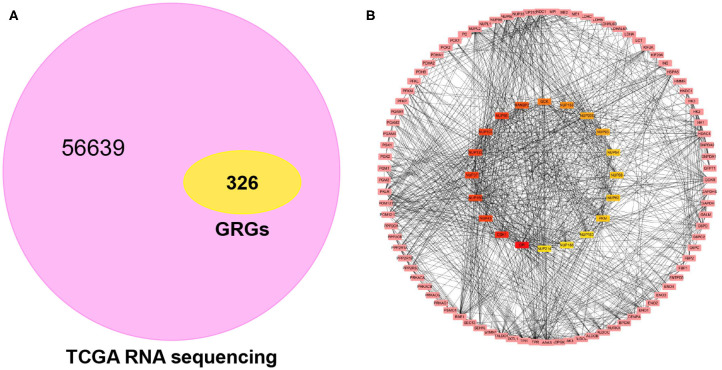
Overview of glycolysis-related genes (GRGs) in the TCGA GC training cohort. (A) Venn diagram showing that glycolysis-related genes belonged to a subset of the whole RNA sequencing of GC in the TCGA dataset. (B) Network of glycolysis-related genes in GC constructed by Cytoscape.